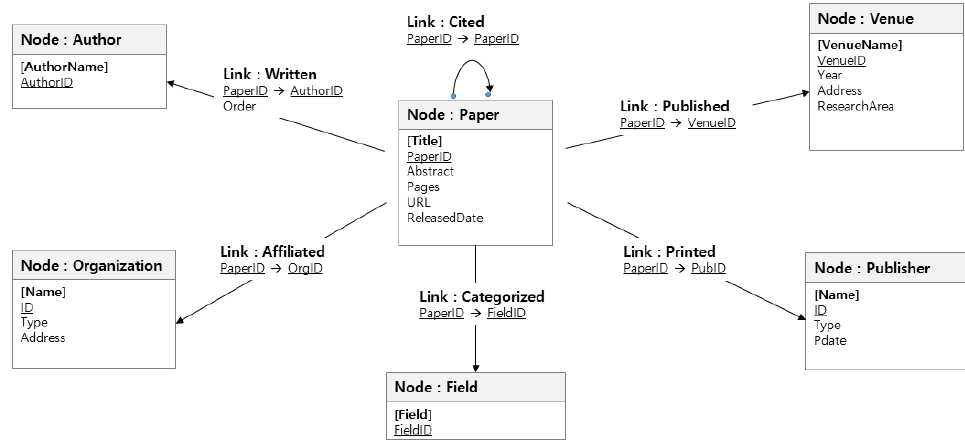
Figure 6. Database Schema for